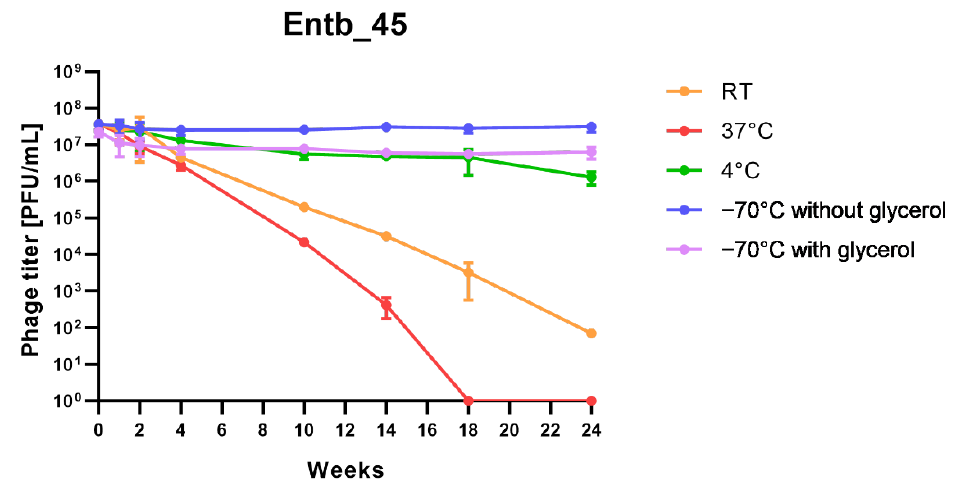
Figure 10. Long-term stability of Entb_43 and Entb_45 phage lysates under various temperature conditions. Error bars represent the standard deviation (±SD) of the mean phage titers.